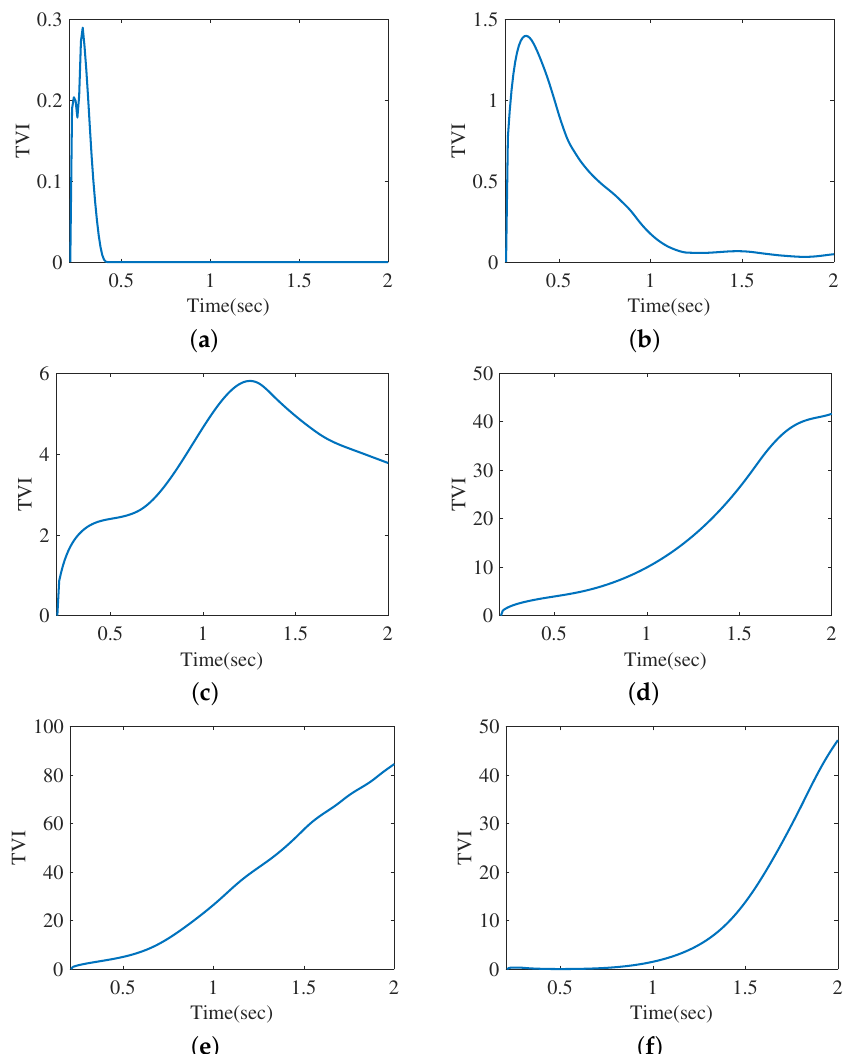
Figure 7. TVI tot calculated for defined scenarios: ( a ) Case a, ( b ) Case b, ( c ) Case c, ( d ) Case d, ( e ) Case e, ( f ) Case